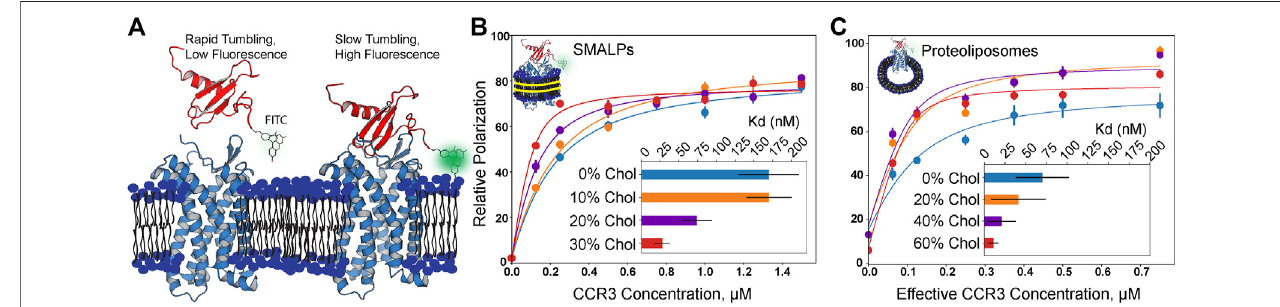
FIGURE5| Fluorescencepolarizationassayresultsinincreasingcholesterolcontent(mol%inPC). (A) Visualizationofapo-andCCR3-boundCCL11.FITC-labeled CCL11 is rapidly tumbling in solution, and thus, the probe polarizes light to a lesser degree. Upon binding CCR3, tumbling is slowed, polarizing a greater fraction of light and givingrisetoalargerpolarizationvalue.CCL11(PDBID1EOT)(Crumpet al.,1998)wasdockedtoCCR3 usingHADDOCK (vanZundertet al.,2016)tovisualizethe bound stateleadingtoslowertumbling. (B) Membrane cholesterolcontentispositivelycorrelatedwithincreasedligandaf fi nityinSMALPs. (C) Increasedobserved af fi nity is conserved in proteoliposomes. Concentration is halved to correct for receptor orientation ( Supplementary Figure S3 ). Points indicate the mean ± SEM for three replicates, each read three times. Error bars may fall within the size of the points. Data were normalized by subtracting the lowest zero-point (no CCR3) value in a curve from each read to bring all curves within the same reference